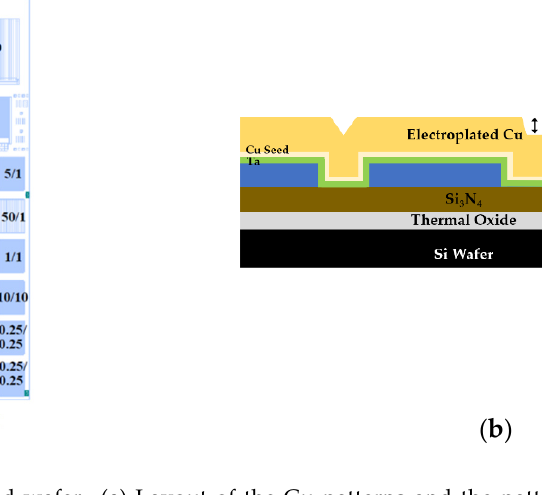
Figure 3. Information on the Cu-patterned wafer. ( a ) Layout of the Cu patterns and the patterns considered in the experiment and ( b ) the cross-sectional view of the patterned